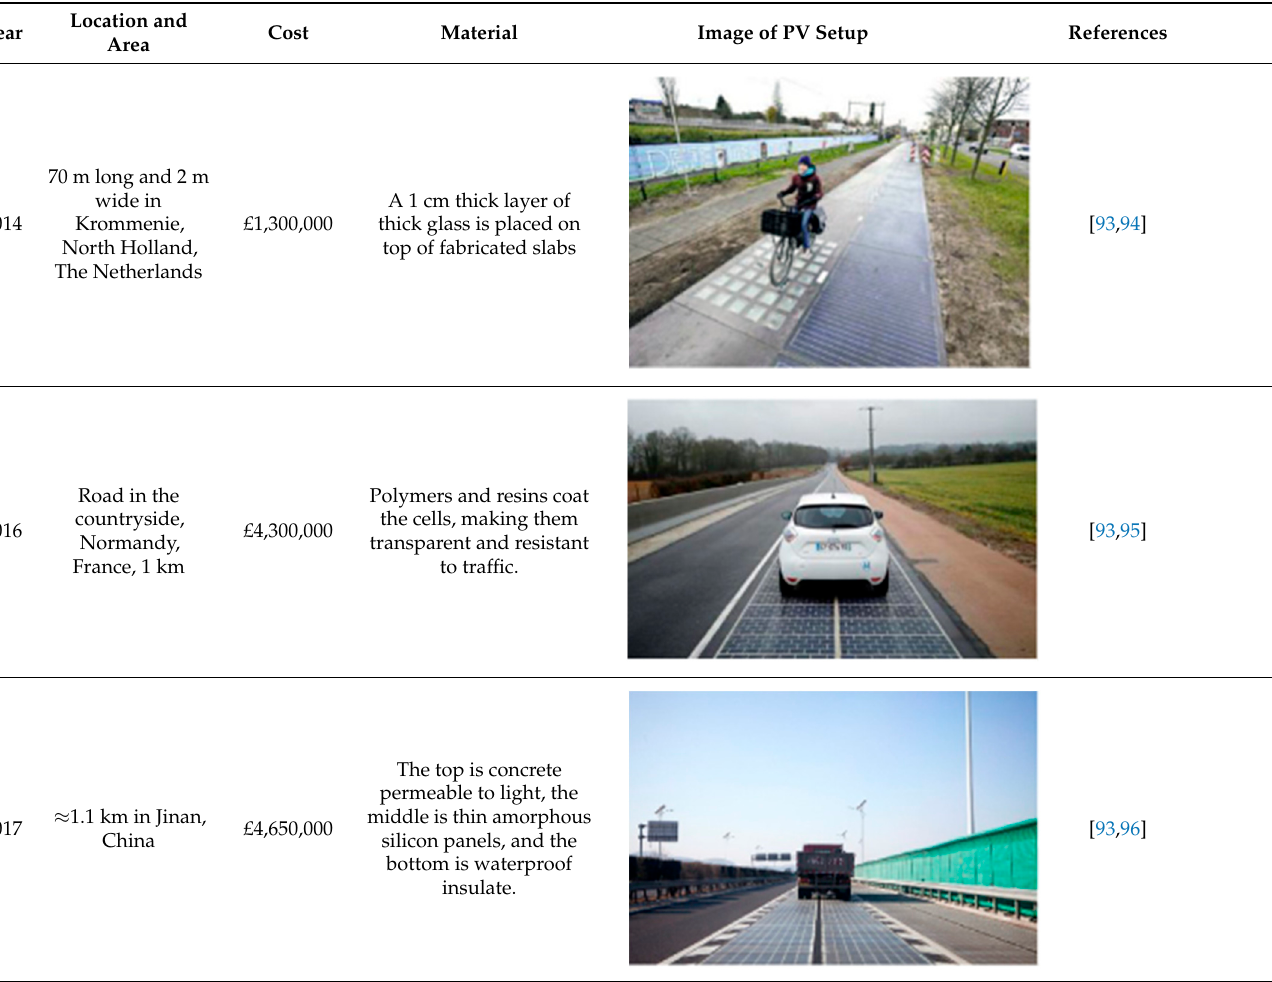
Table 2. Summary of currently available solar roads.